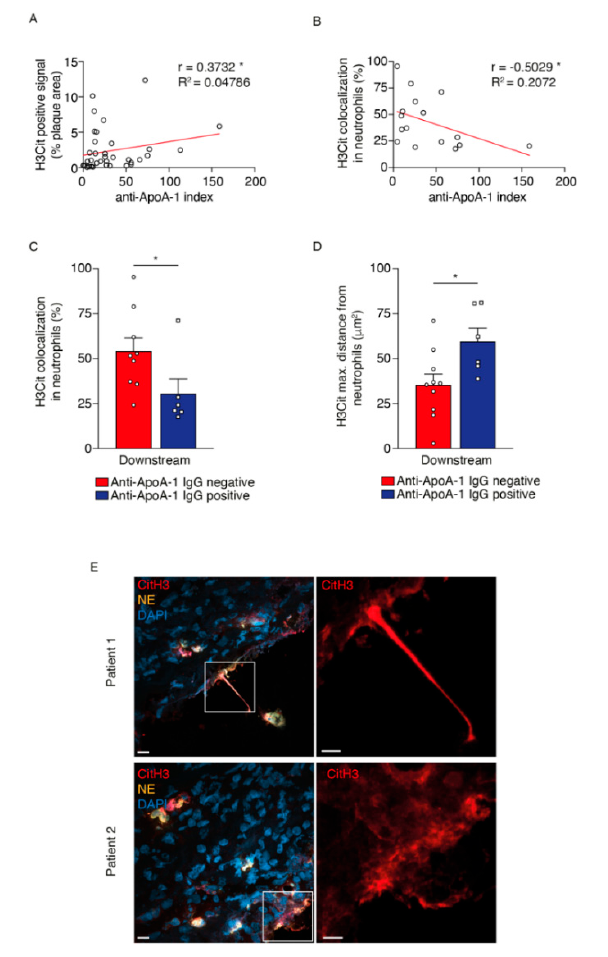
Figure 5. Distinct pattern of citrullinated histone-3 (H3Cit) expression in patient serum positive versus negative for anti-apolipoprotein A-1 IgG (ApoA-1). Spearman correlation coefficients between ( A ) H3Cit positive signal, ( B ) H3Cit colocalization in neutrophils and anti-ApoA-1 index. Quantitative average H3Cit